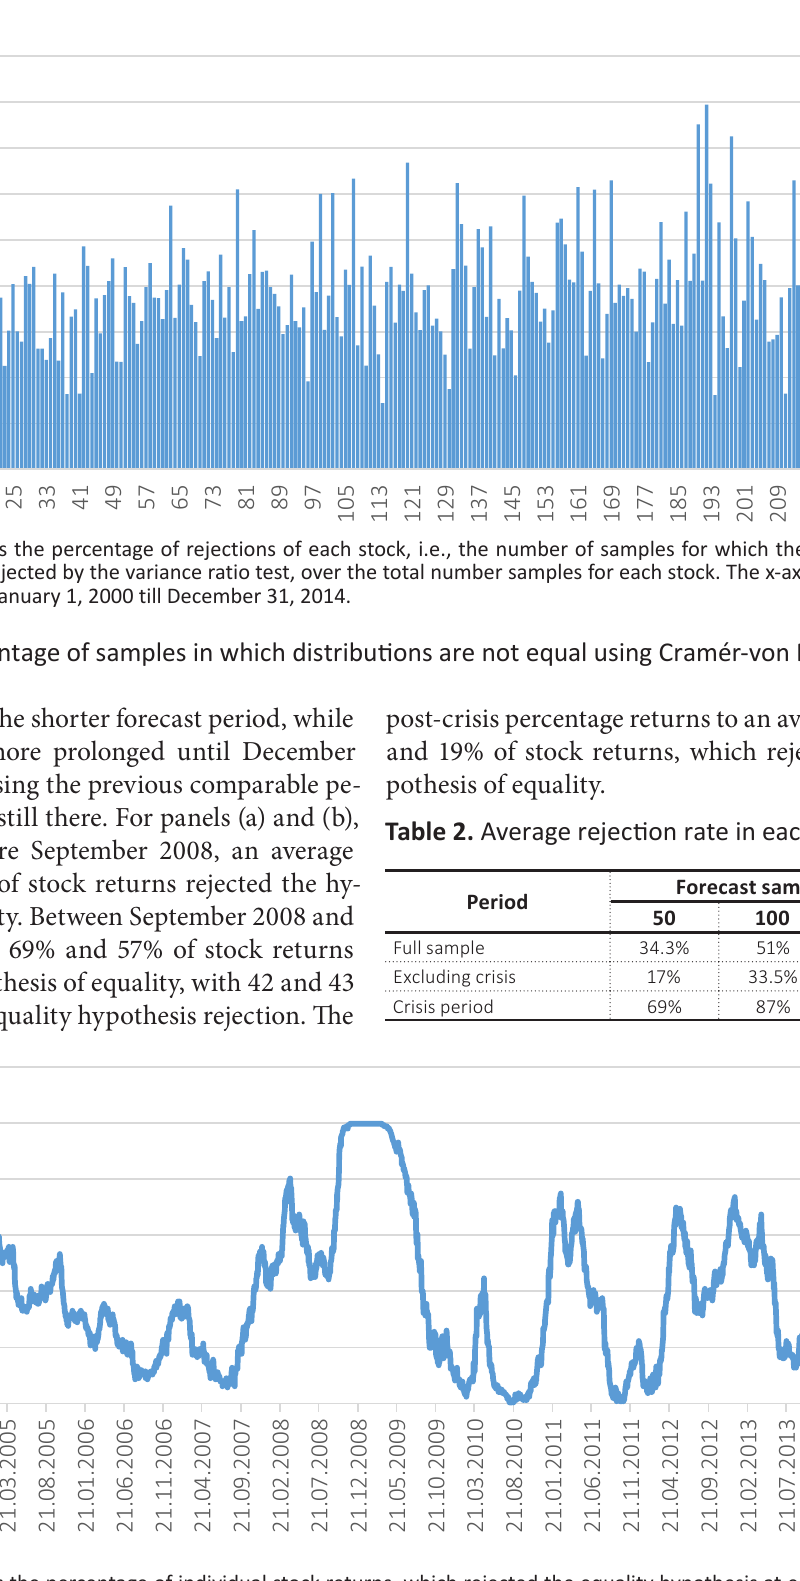
Figure 5. One-hundred (100) observation forecast sample using Cramér-von Mises